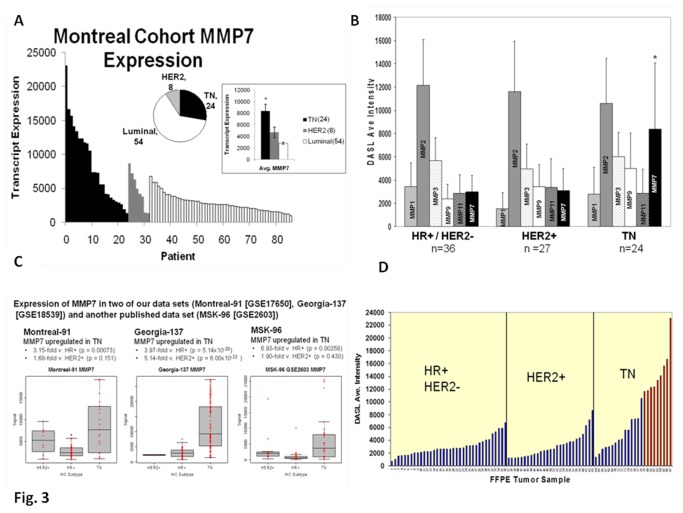
Expression of MMP7, one of the transcriptional targets of the WP as compared to other members of the MMP family in different subtypes of breast tumor samples from the Montreal and Georgia cohorts.(A) Figure shows MMP7 expression in the Montreal cohort. Expression of MMP7 is higher in the TN subtype. Expression is sorted from the highest to the lowest level for TN (black), HER2+ (grey), and luminal (white) breast tumor subtypes as classified by IHC. Inset shows average expression of MMP7 by subtype in the cohort. Average expression of MMP7 is significantly higher (P< 0.05) in the TN (black) subtype as compared to both the HER+ (grey) and luminal (white) subtypes as indicated by the asterisk. Numbers within bracket are the patients in each subtype. (B) Figure shows selective upregulation of mRNA for MMP7 in TN tumors of the Montreal cohort as evident from the DASL assay average intensity data for different metalloproteinases. Expression of MMP1, MMP2, MMP3, MMP9, MMP11 and MMP7 grouped by hormone receptor and HER2 status; HR+/HER2-, HER2+, and TN. HR+ (hormone receptor+) is ER+ and/or PR+; HER2+ is HER2-positive and HR±; TN is triple negative. Error bars represent STDEV. Level of transcript expression is represented by DASL average intensity. *P< 0.05, and n represents number of samples in each subset. (C) Figure shows the expression of MMP7 with respect to IHC subtypes in two of our data sets (Montreal-91 [GSE17650], Georgia-137 [GSE18539]) and another published data set (MSK-96 [GSE2603]). The expression of mRNA for MMP7 is significantly upregulated in TN as compared to the luminal subtype (HR+) in all the sets and HER2+ subtype in the Georgia-137 cohort (p = 6.00×10-22). The expression of the mRNA for the gene is significant in univariate analysis (p < 0.01). (D) The upregulation of MMP7 mRNA is observed in a subset of TNBC specimens as shown by the bar graph of the expression of MMP7 in each tumor in the cohort. Bars represent MMP7 mRNA expression in 87 FFPE breast tumor specimens (36 HR+/HER2- tumors, 27 HER2+/ HR± tumors and 24-TN tumors from the Montréal cohort) grouped by hormone receptor and HER2 status. MMP7 expression was upregulated in a subset ~40% (9/24) of TN tumor samples (shown in red) but not in any of the other (0/63) tumor samples (shown in blue).